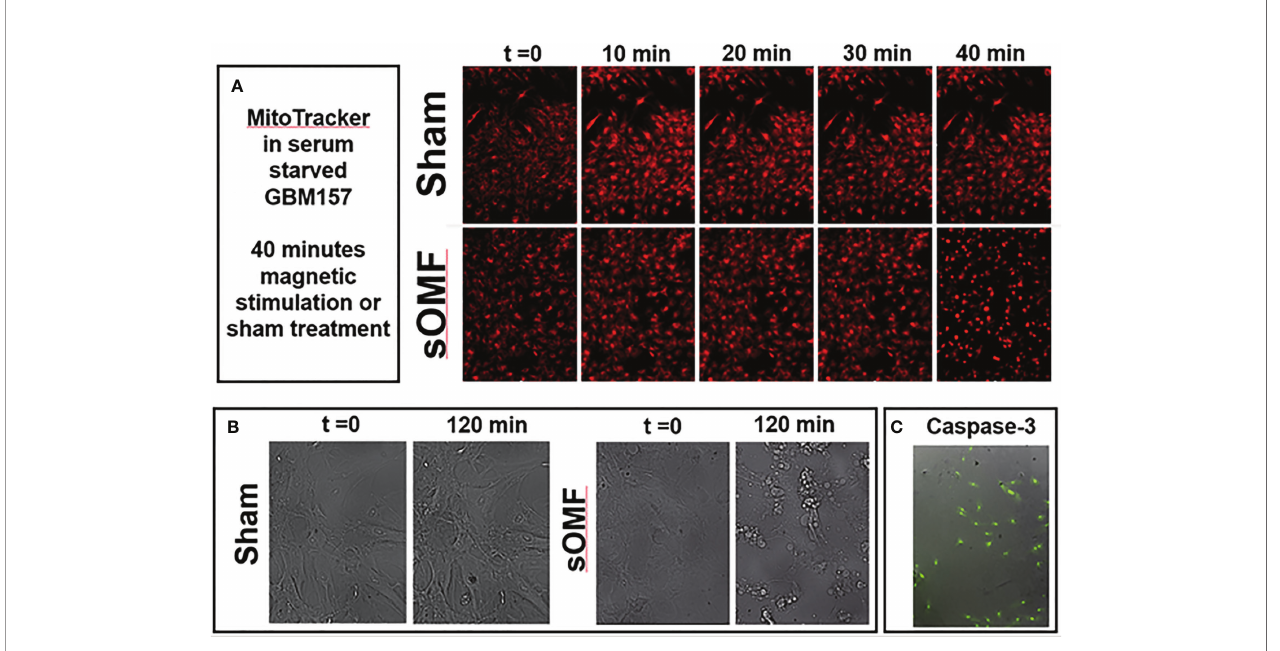
FIGURE 8 | sOMF kills non-dividing GBM cells via effects on their mitochondria. (A) Serum-starved, non-dividing GBM cells stained with MitoTracker ™ and stimulated with sOMF or sham were observed over 40 min by time-lapse video fl uorescence microscopy. Image frames at fi ve time points demonstrate that cell death in the sOMF-treated but not sham-treated cultures at 40 min. Paired sOMF (B) and sham-treated (C) serum-starved cultures, examined using bright fi eld microscopy, also show morphological cell death only with sOMF treatment., and with green fl uorescence indicating activation of the caspase-3 apoptotic pathway in sOMF-treated, but not sham-treated (data not shown) cell cultures.